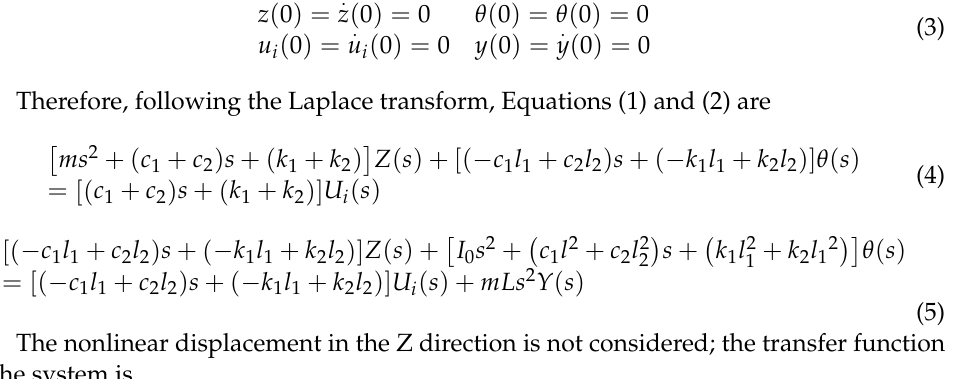
where m is the mass of the end effector; I 0 is the rotational inertia; k 1 , k 2 is the rigidity of the vibration isolator; c 1 , c 2 is the damping coefficient; l 1 , l 2 is the distance from the vibra- tion isolator to the center of mass; L is the distance from the center of mass to the vibration isolator; u i is the linear displacement of the end effector; y is the linear displacement through the vibration isolator; and z , θ are the linear displacement of the end effector on Z direction and the angular displacement around the center of mass. The initial conditions are